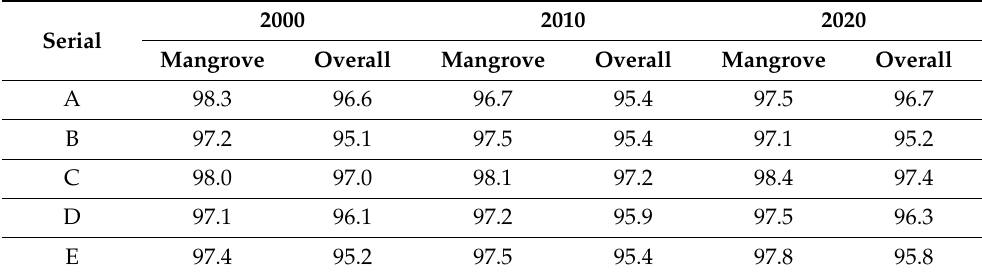
Table 4. Accuracy assessment